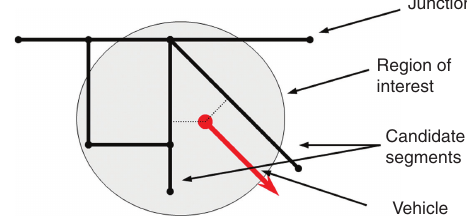
Figure 2. Map Matching in a